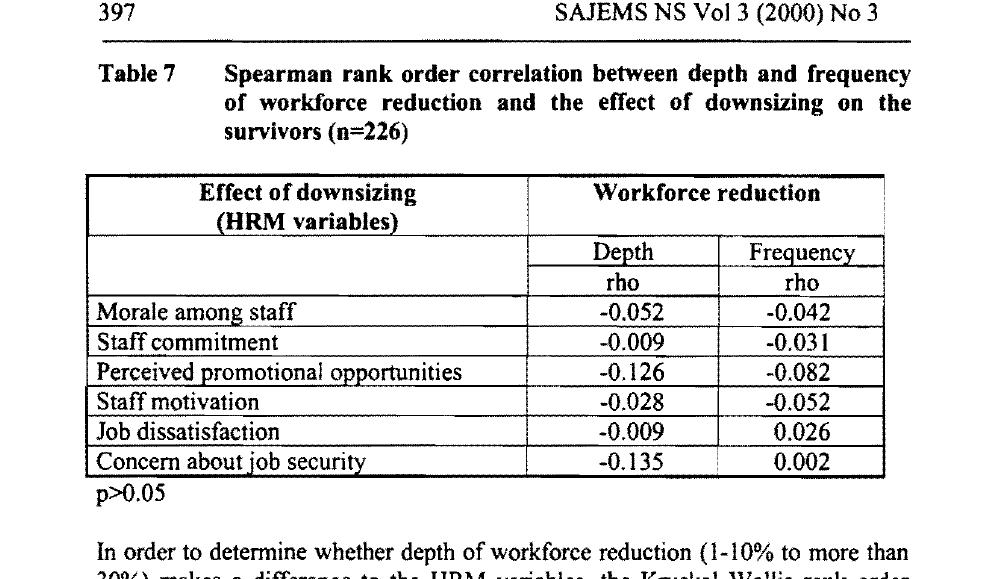
Kruskal Wallis rank order analysis of variance for depth in workforce reduction in respect of the effect of downsizing on the survivors